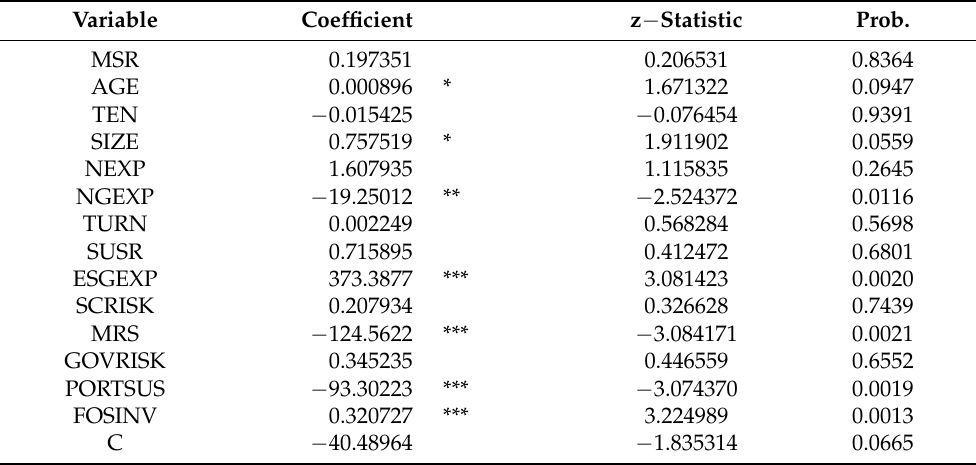
Table 8. Impact of fund characteristics on the price transmission from mutual fund flows to oil prices. Variable Coefficient z − Statistic Prob.